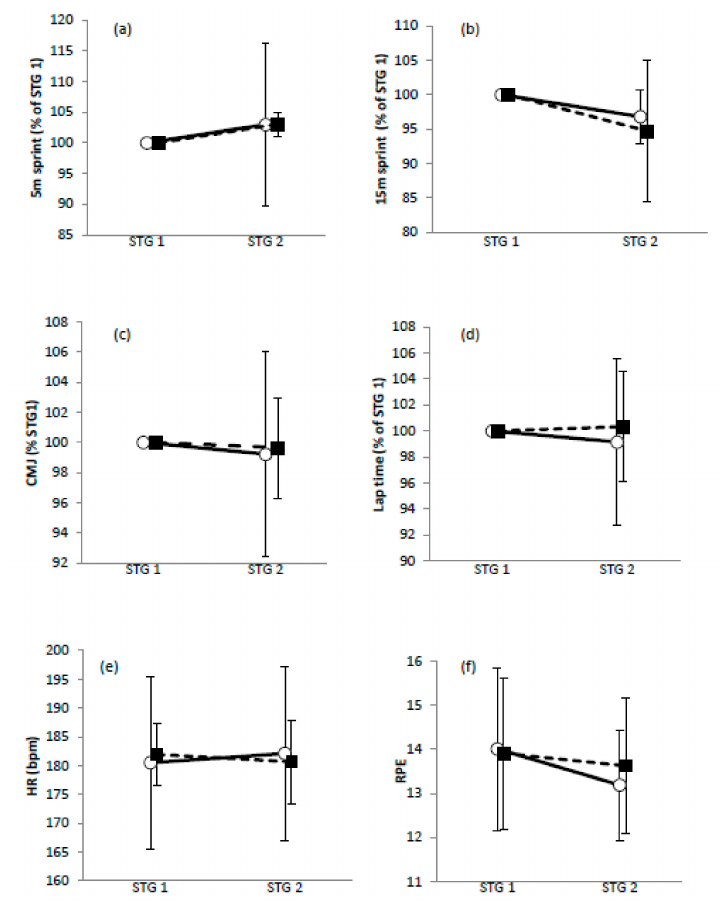
Figure 2. Mean values for simulated team game (STG) 1 vs. STG 2 ( a ) 5 m sprint performance; ( b ) 15 m sprint performance; ( c ) countermovement jump performance; ( d ) lap time; ( e ) heart rate; ( f ) rate of perceived exertion. Values are presented as the mean ±